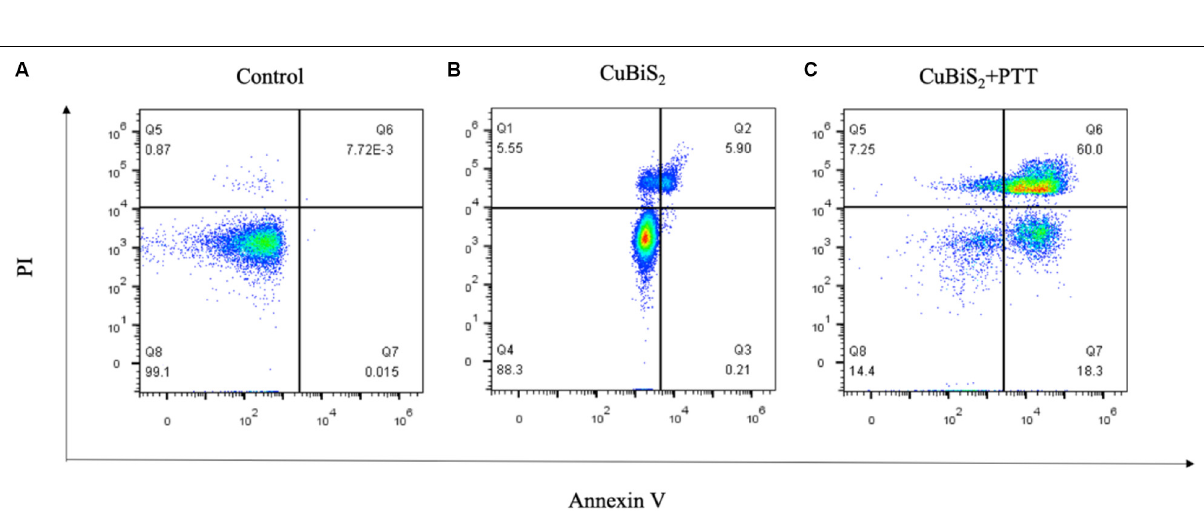
FIGURE 5 | CuBiS 2 NPs based PTT induced apoptosis of macrophages. Flow cytometry analysis of Raw264.7 apoptosis after different treatments: (A) Control; (B) CuBiS 2 ; (C) CuBiS 2 + PTT. Cell apoptosis was detected by flow cytometry with annexin-V-FITC and PI. CuBiS 2 NPs + PTT group showed higher early (Q7) and mid/late (Q6) apoptosis index than CuBiS 2 group.